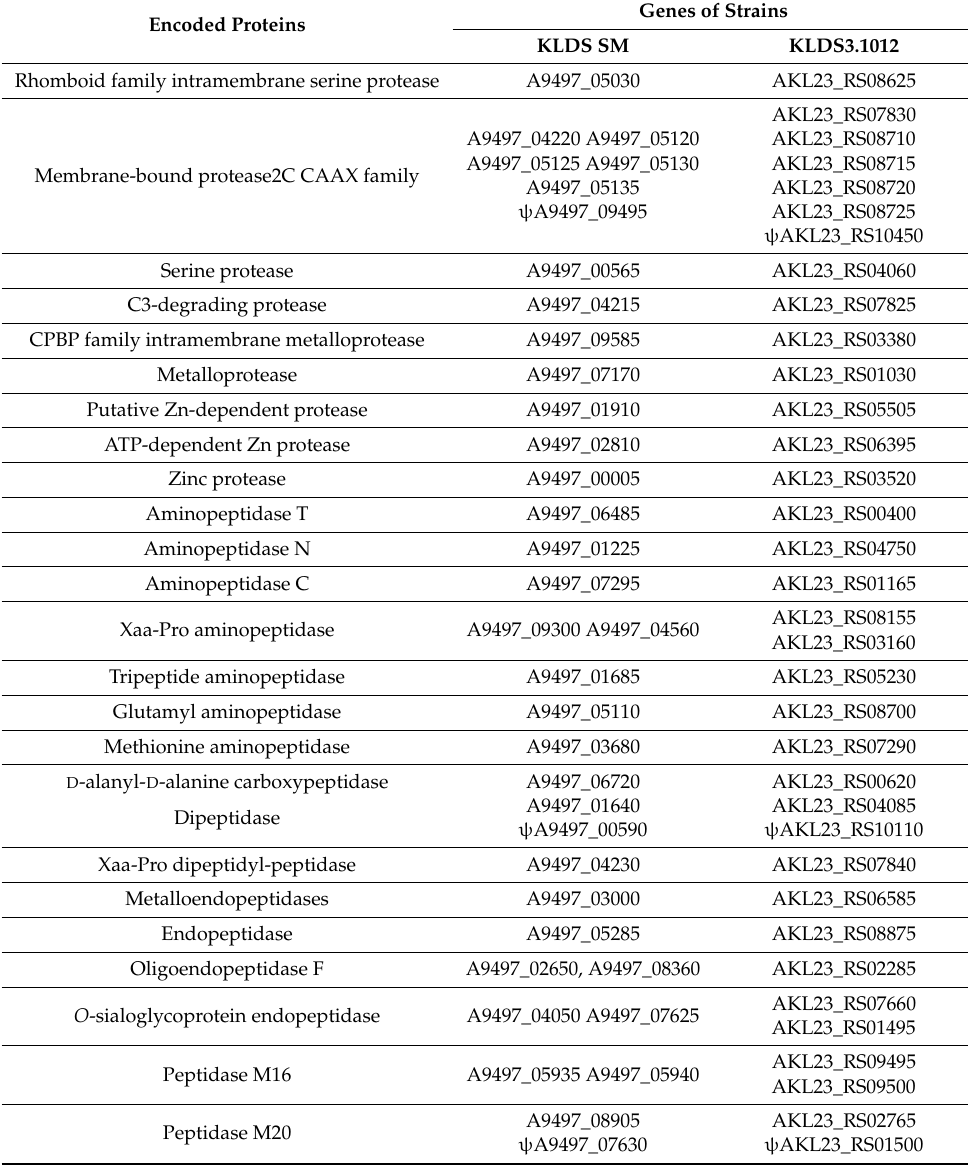
Genes of Strains KLDS SM KLDS3.1012